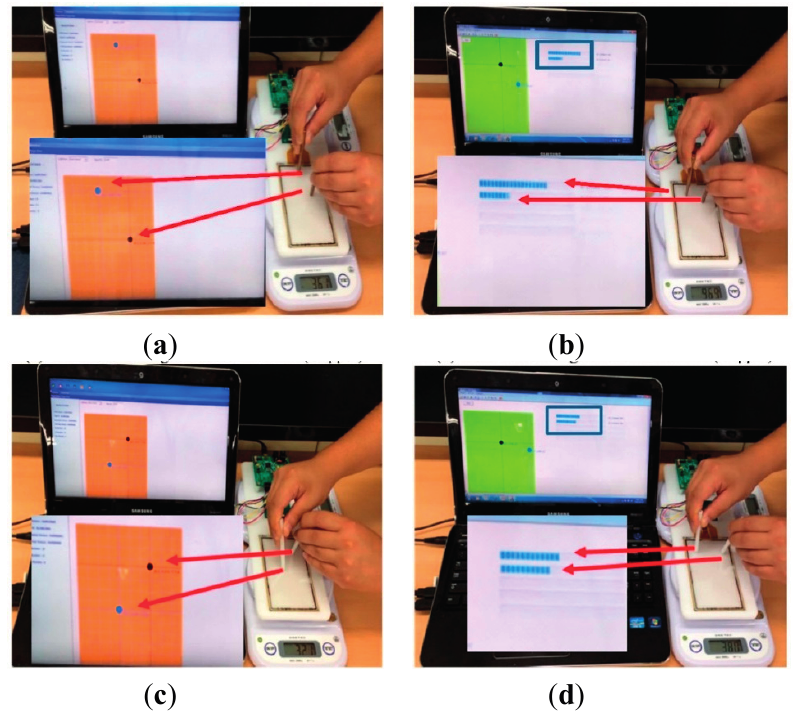
Figure 7. Operational performance of the force sensing touchscreen which was connected to the electrical board; ( a ) Multi-touch using conductor material (Copper); ( b ) Multi-force using conductor material (Copper); ( c ) Multi-touch using non-conductor material (Teflon) and ( d ) Multi-force using non-conductor material (Teflon) were displayed on the touch awareness program developed. The black and blue points represent touch positions and the intensity of the applied touch force was displayed by the movement of the scale bar (Arbitrary